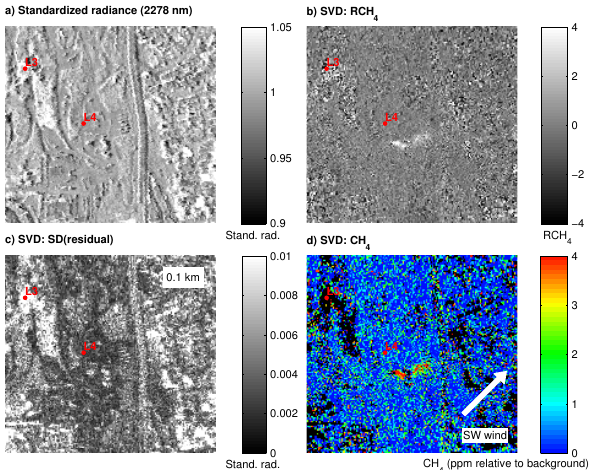
Fig. 12. (a) Standardized radiance used for calculating SVD for In- glewood subset (showing only 2278nm). (b) For the same image subset, RCH 4 results indicate CH 4 plume at the center of the scene. (c) The standard deviation of the residuals (measured minus mod- eled radiance). (d) ppm CH 4 relative to background, excluding pix- els with greater than 0.0075 standard deviation of the residual (a unitless value given the SVD was performed on standardized radi- ance). For two spectra (indicated by locations L3 and L4), measured and modeled radiance are provided in Fig. 13.